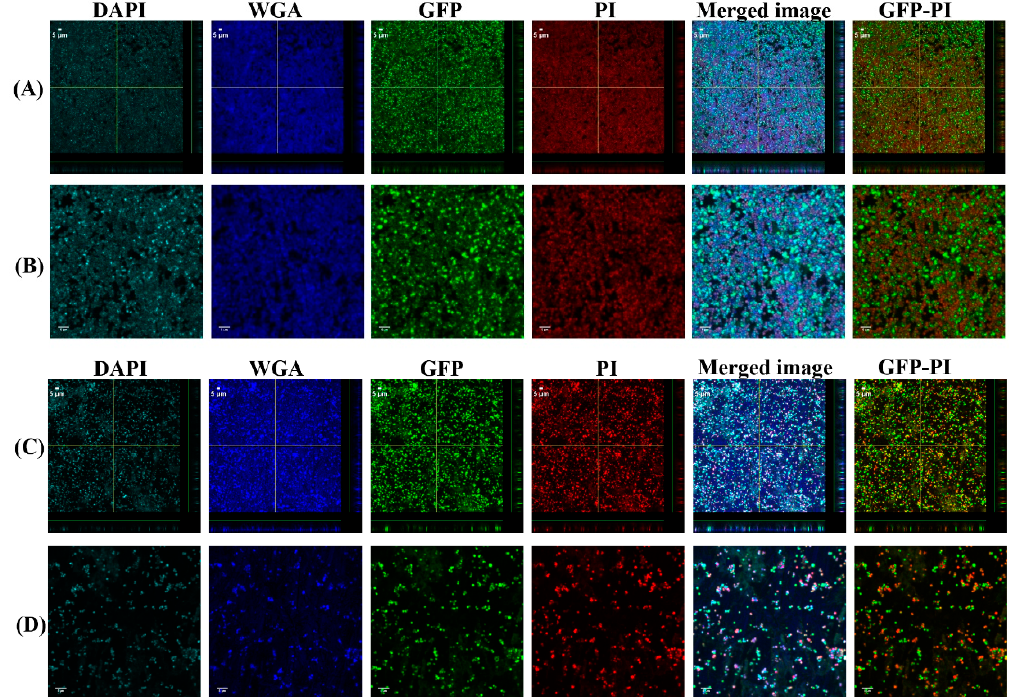
Figure 7. Confocal images of aggregated ( A , B ) and single cells ( C , D ) biofilms for 10 3 CFU/mL after 3 h antibiotic treatment. Panel B and D are zoomed images. Biofilms stained with DAPI for eDNA, WGA stain for PNAG or SF-derived HA, and PI for staining dead cells. Merged images denote the combination of DAPI, WGA, GFP, and PI images. GFP-PI is combi- nation of GFP and PI images.